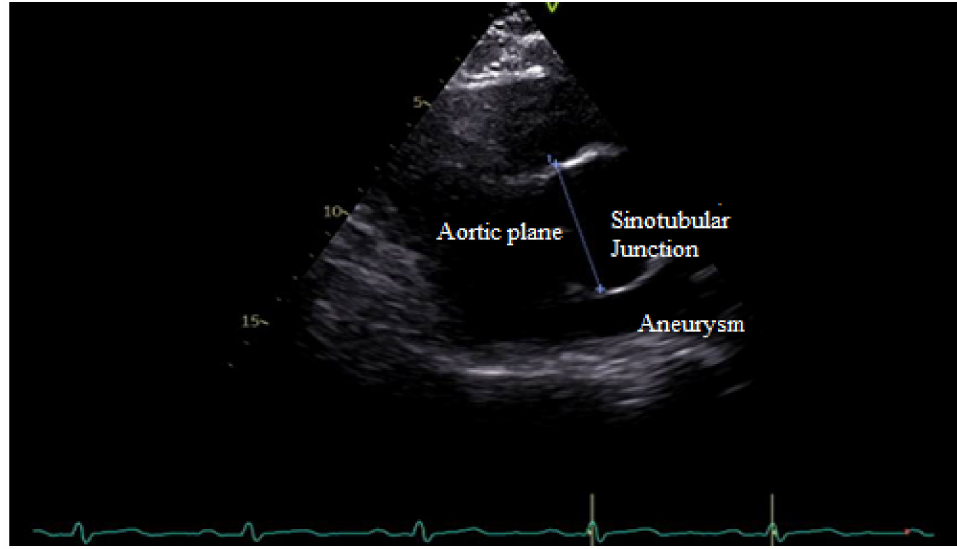
Figure 6. TTE shows enlargement of the sinotubular junction related to R-L cusp